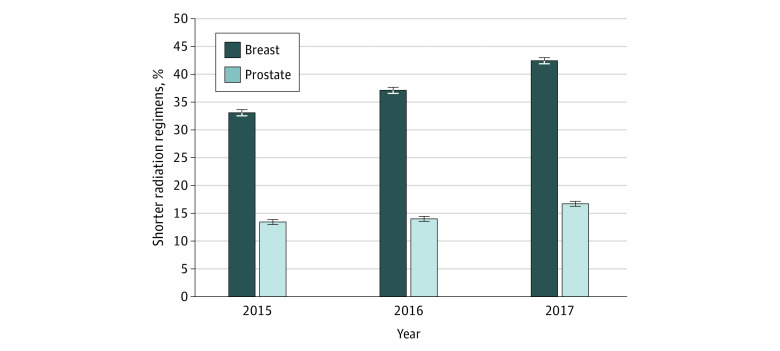
Proportion of Shorter Radiation Regimens for Breast and Prostate Cancer, 2015 to 2017Bars denote proportion of shorter radiation regimens by each year chronologically and stratified by cancer type, with overlying lines to demonstrate the longitudinal trend. Error bars denote 95% confidence intervals.